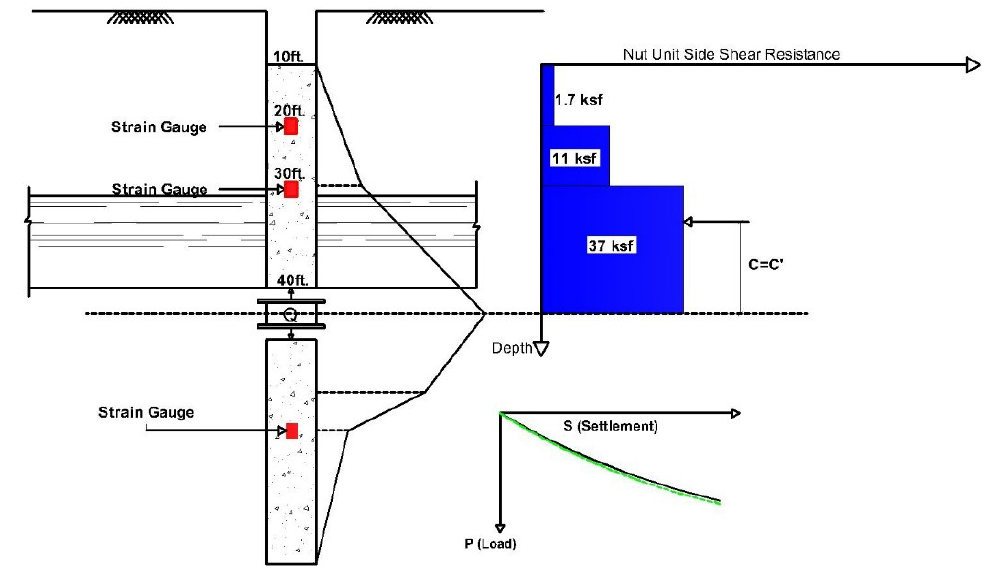
Figure 16. Unit side resistance and load–settlement comparison for the Osterberg test and conventional test (Case Study